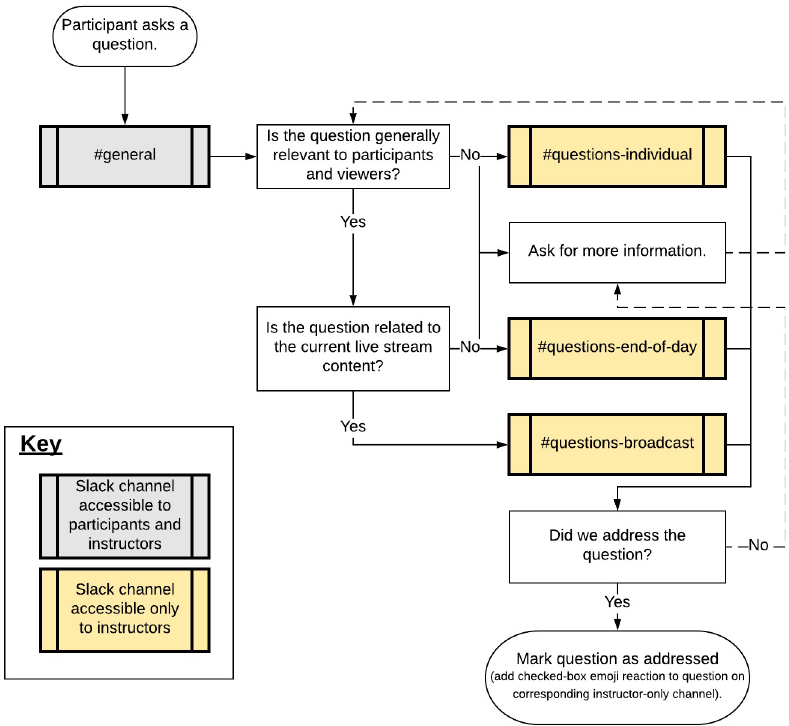
Fig 3. Triage protocol for questions from participants. All questions from participants were asked on Slack. Questions were triaged by the triage leader as they were asked.